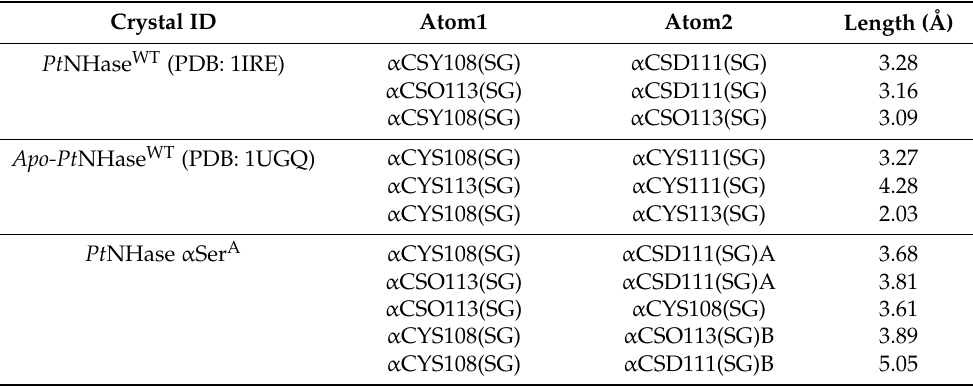
Table 3. Selected bond